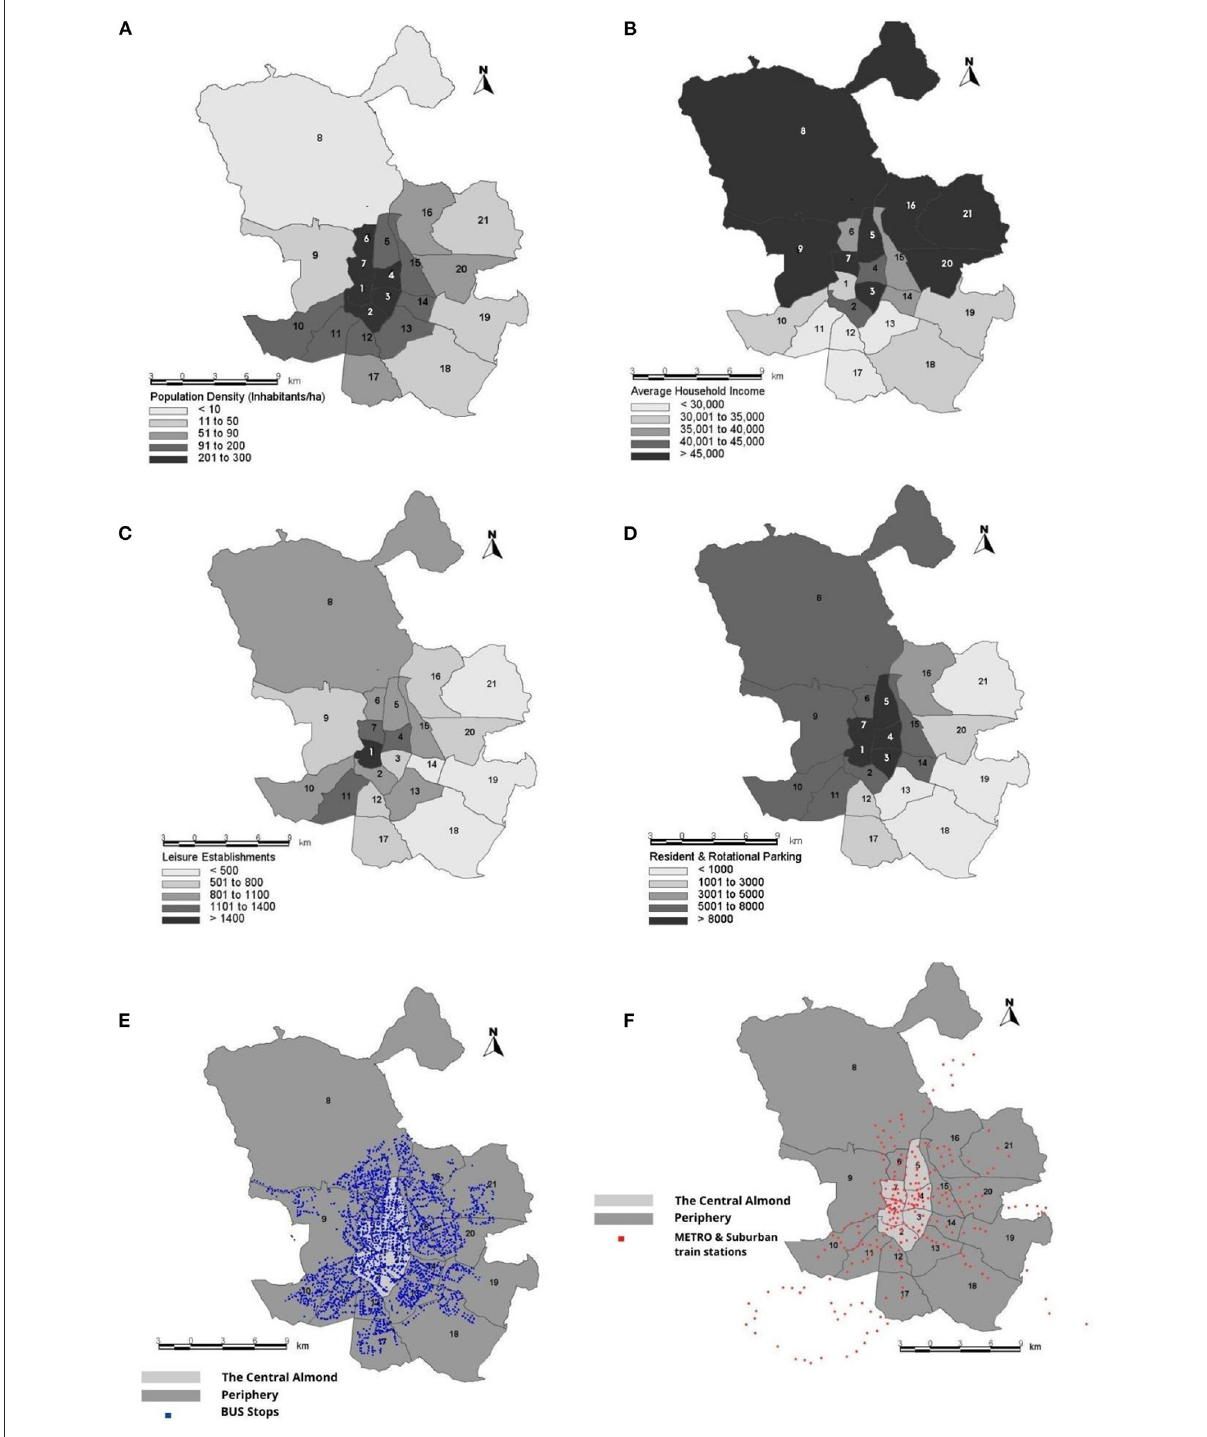
FIGURE3 Spatial distribution of the independent variables analyzed: (A) Average population density in the districts of Madrid analyzed in the period 2013–2019; (B) Average household income in the districts of Madrid analyzed in the period 2013–2019; (C) Average number of leisure establishments in the districts of Madrid analyzed in the period 2013–2019; (D) Average number of parking spaces for residents and rotational spaces in the districts of Madrid analyzed in the period 2013–2019; (E) Location of the bus stops in the districts of Madrid; (F) Location of metro stations in the districts of Madrid. 1-Center; 2-Arganzuela; 3-Retiro; 4-Salamanca; 5-Chamartín; 6-Tetuán; 7-Chamberí; 8-Fuencarral-El Pardo; 9-Moncloa-Aravaca; 10-Latina; 11-Carabanchel; 12-Usera; 13-Puente de Vallecas; 14-Moratalaz; 15-Ciudad Lineal;